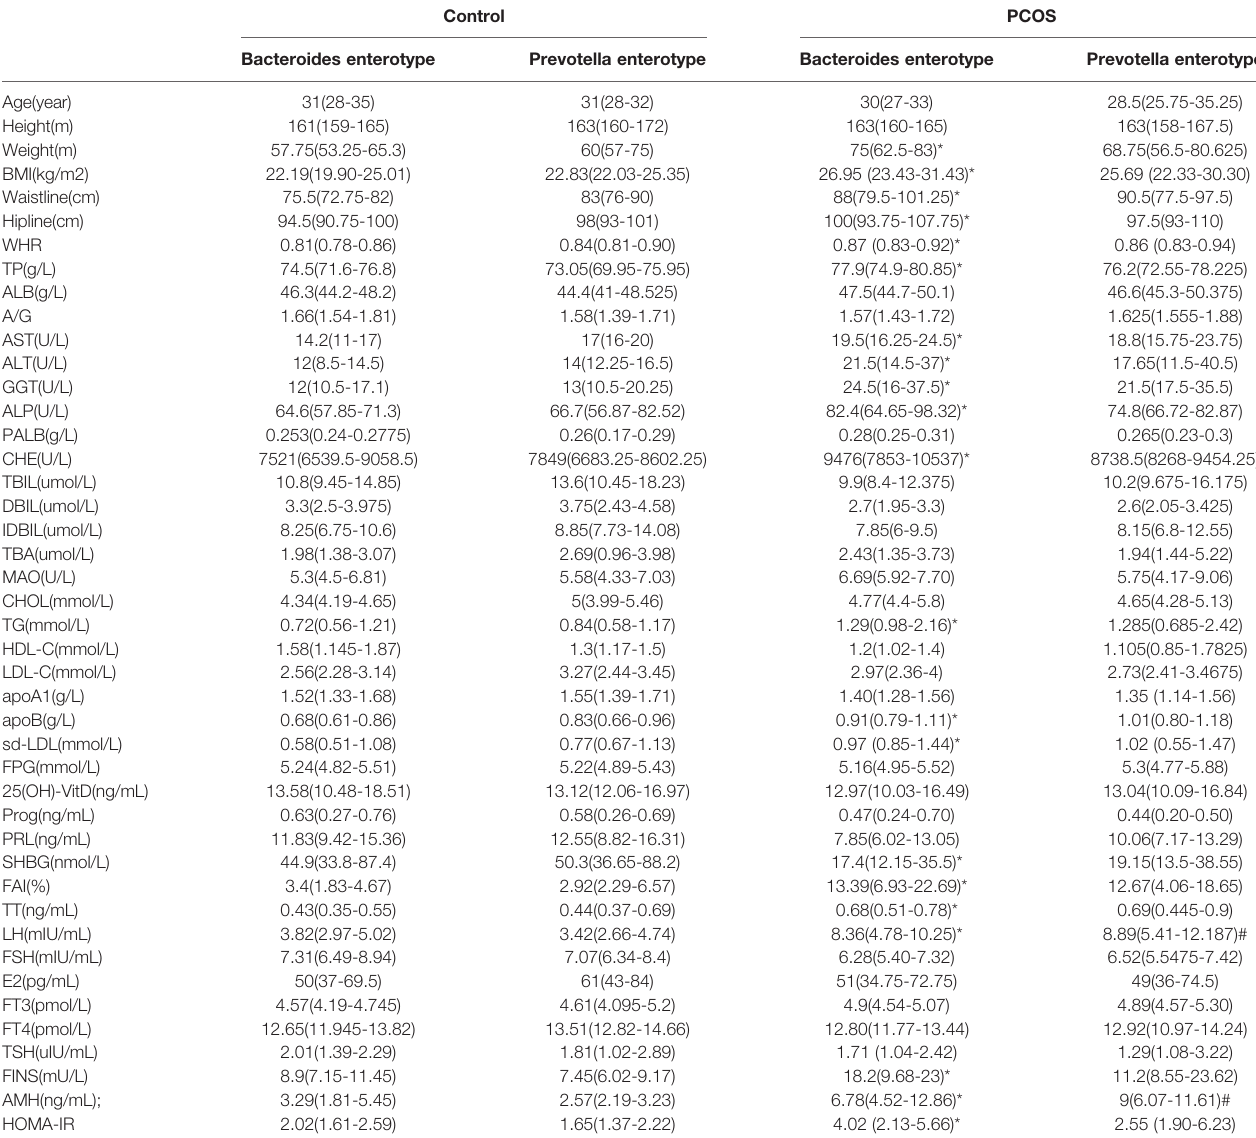
TABLE 1 | Clinical parameters of PCOS participants classi fi ed by enterotypes.